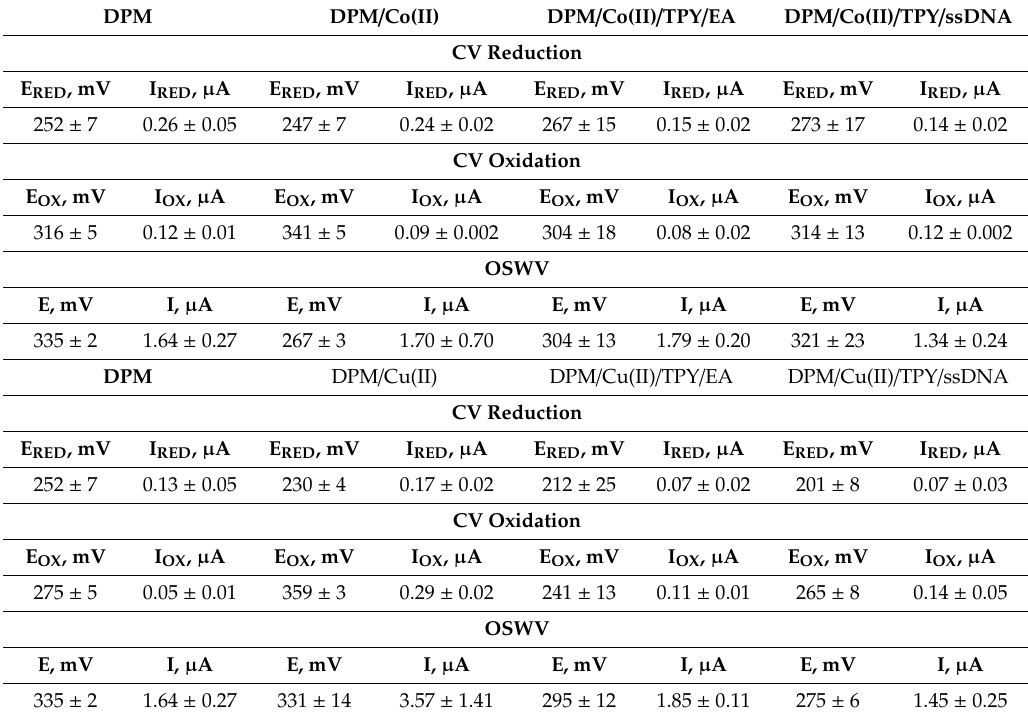
Table 2. Comparison of peak potentials and current values recorded for gold electrodes modified